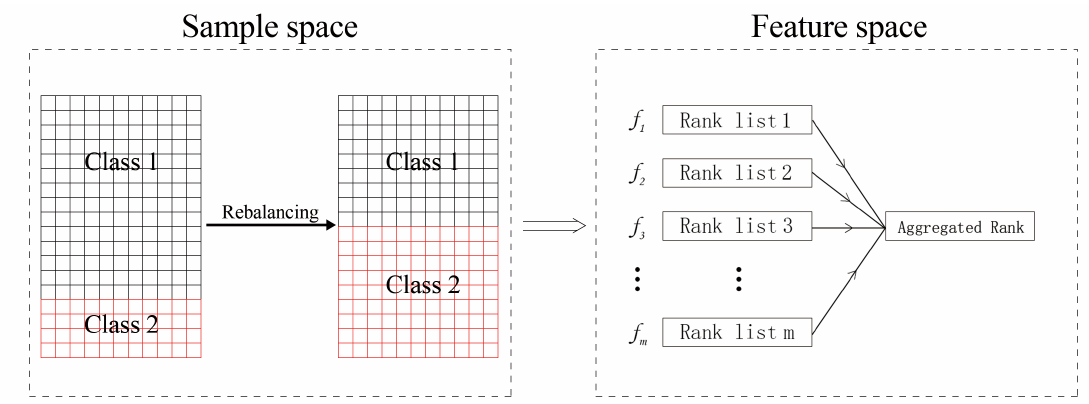
Figure 11. The frame of rank aggregation with